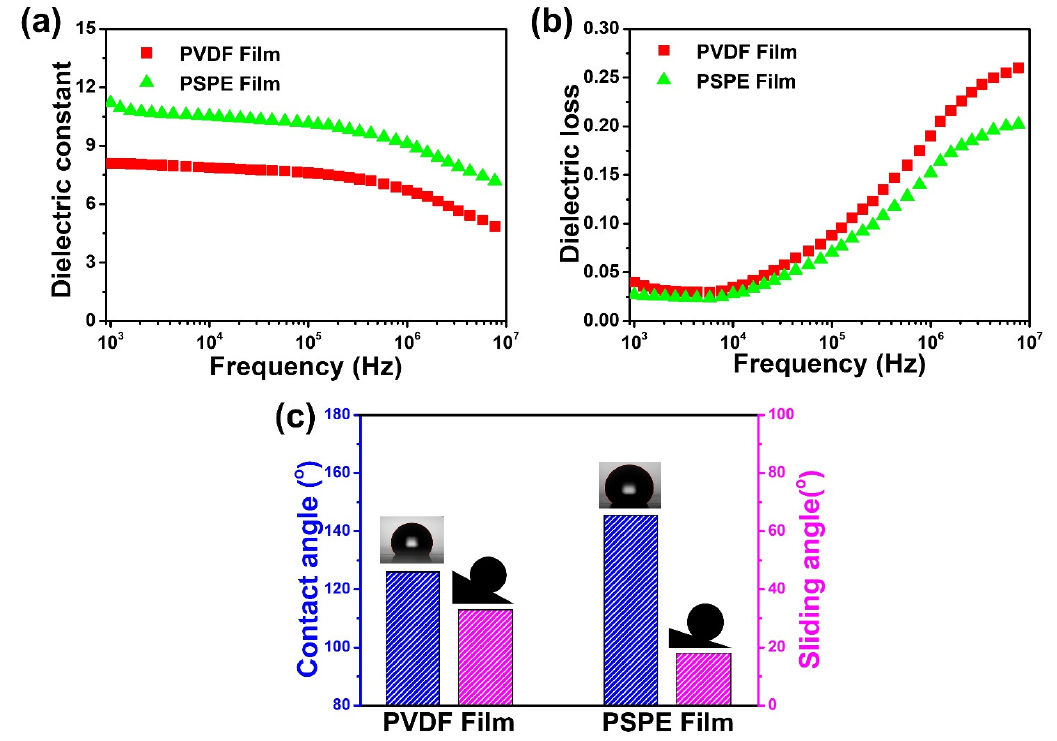
Figure 3. Frequency dependence of ( a ) dielectric constant and ( b ) dielectric loss of PVDF and PSPE films at room temperature; ( c ) contact angle and sliding angle of these films.